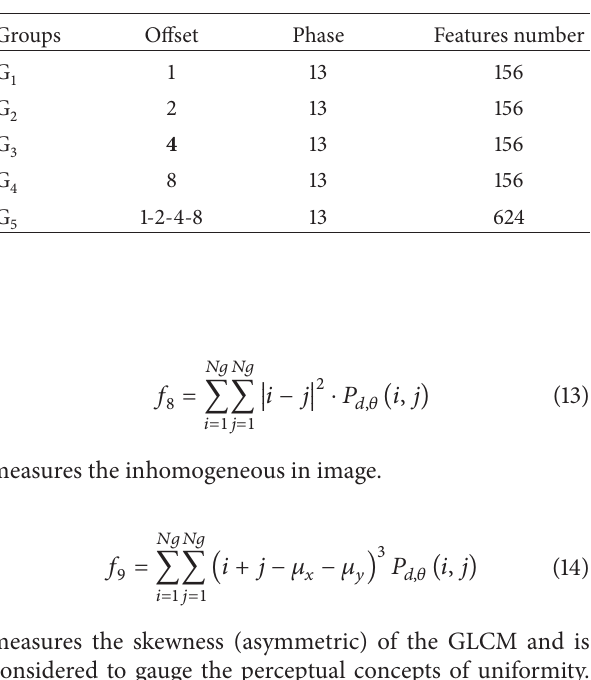
Table 2: Grouping of texture